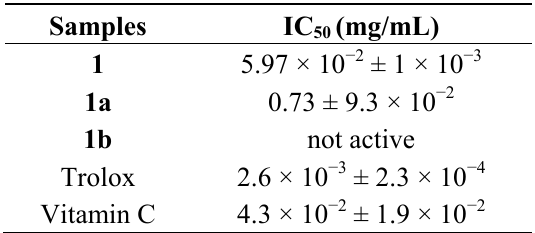
Table 3. IC values of ursolic acid ( 1) and derivatives ( 1a and 1b 50